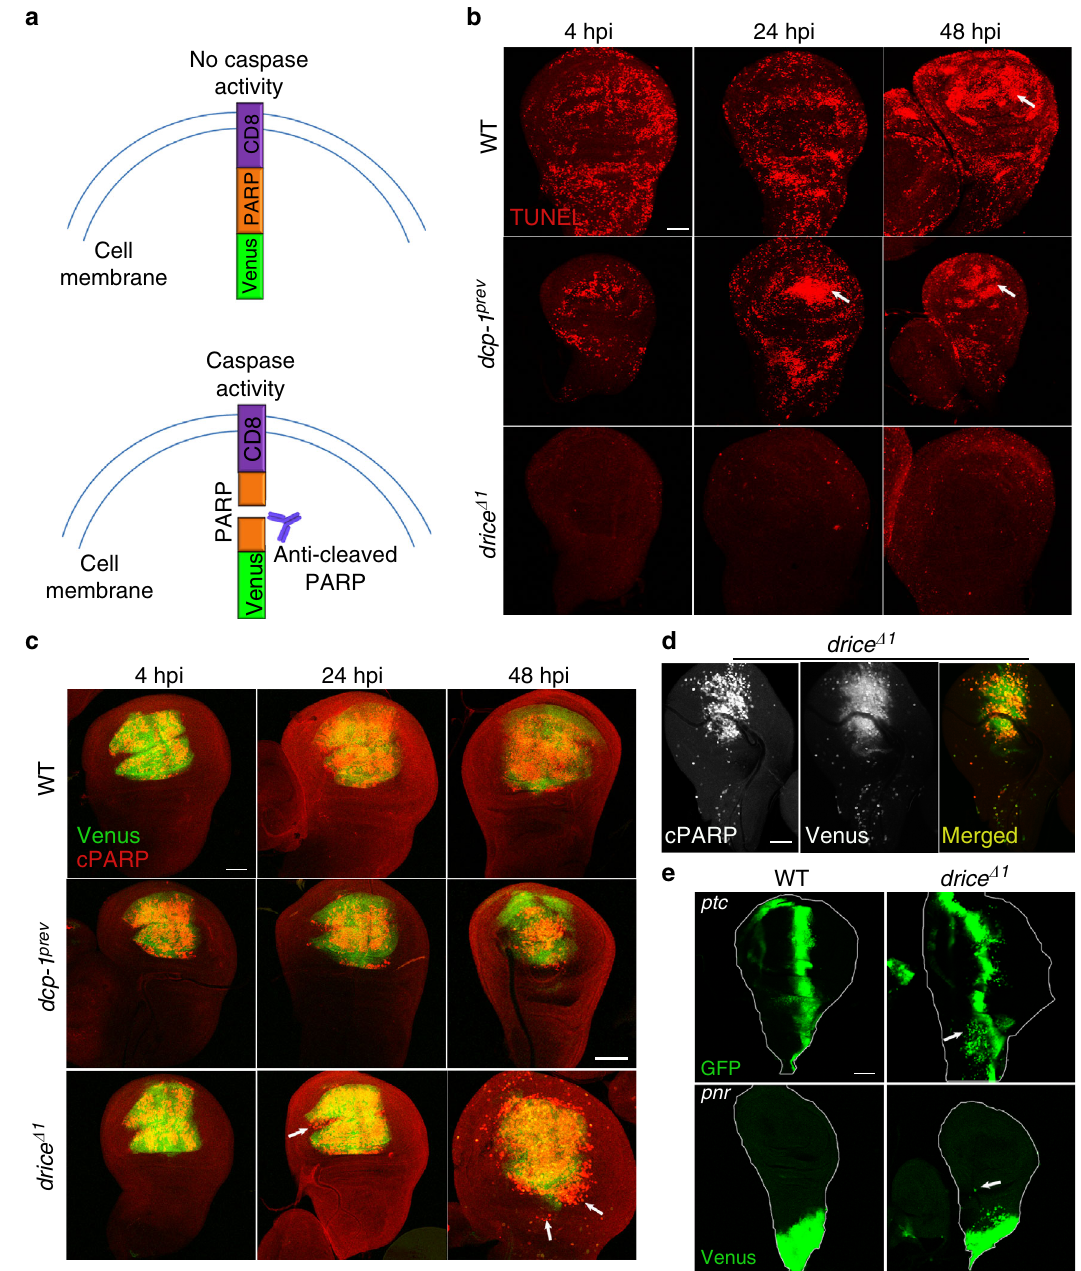
Fig. 1 ICM is induced in drice − / − but not dcp-1 − / − mutants. a A schematic representation of the CPV reporter of effector caspase activity. b Stereotypical clearance of TUNEL labeled cell corpses toward the pouch area (indicated by white arrows) in irradiated WDs. Note that the clearance occurs over more than 48 hpi in both WT and dcp-1 − / − WDs, and that apoptosis is essentially blocked throughout this period in the drice − / − WDs. c Migrating cells in drice − / − WDs display effector caspase (Dcp-1) activity. Effector caspase activity (i.e., CPV cleavage) is detected by an anti-cleaved PARP (cPARP) antibody (red). White arrows indicate cells that migrated away from their expression domain in the pouch area. d A drice − / − WD at 48 hpi (50 Gy) showing that each migrating cell that displays caspase activity also displays Venus. e ICM is induced throughout the irradiated (50 Gy) WDs at 48 hpi. White arrows indicate either GFP- or CPV-expressing cells that migrated away from their expression domains at the anterior – posterior compartment boundary ( ptc ) or the notum region ( pnr ), respectively. Scale bars, 50 µ